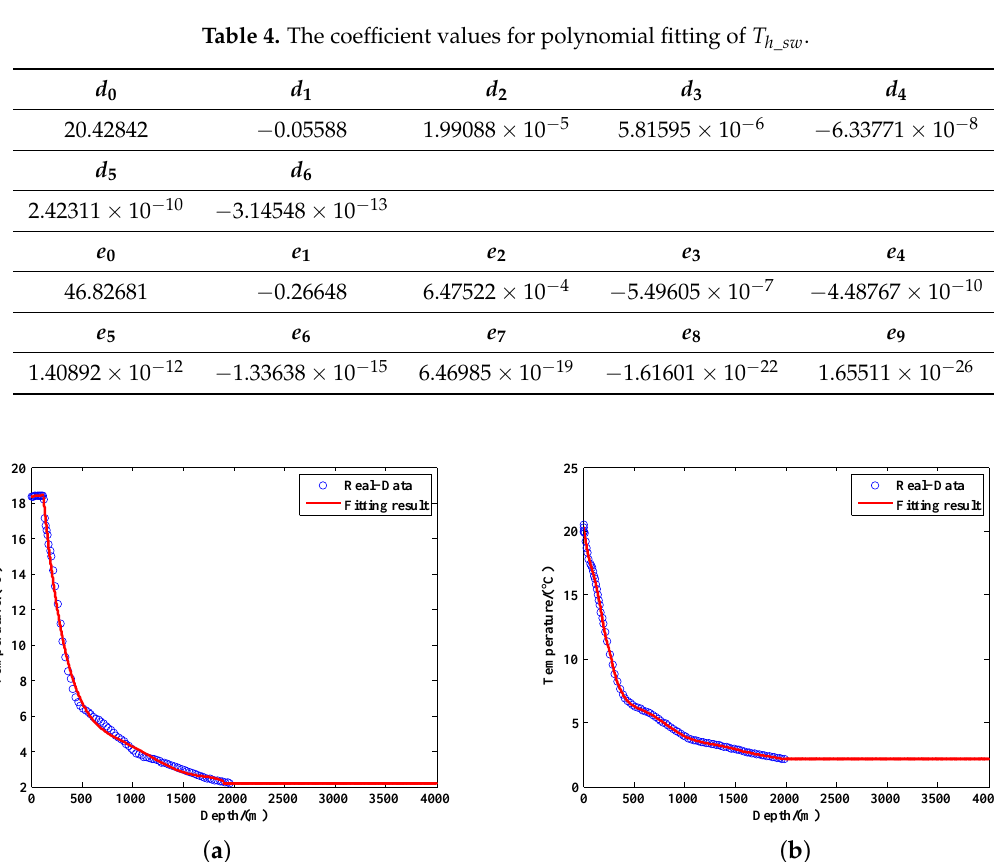
Figure 9. The fitting result of the temperature data in the southern hemisphere. Panel ( a ) shows the seawater’s temperature data in summer and ( b ) shows the seawater’s temperature data in